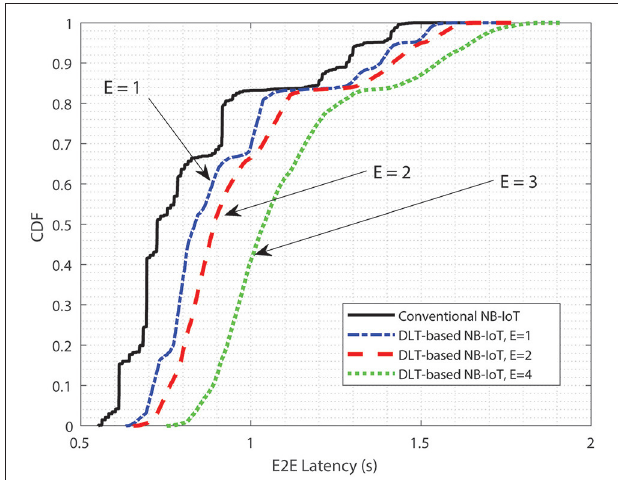
FIGURE 3 | End-to-end latency performance of the proposed integration between DLT and NB-IoT with different number of endorsed